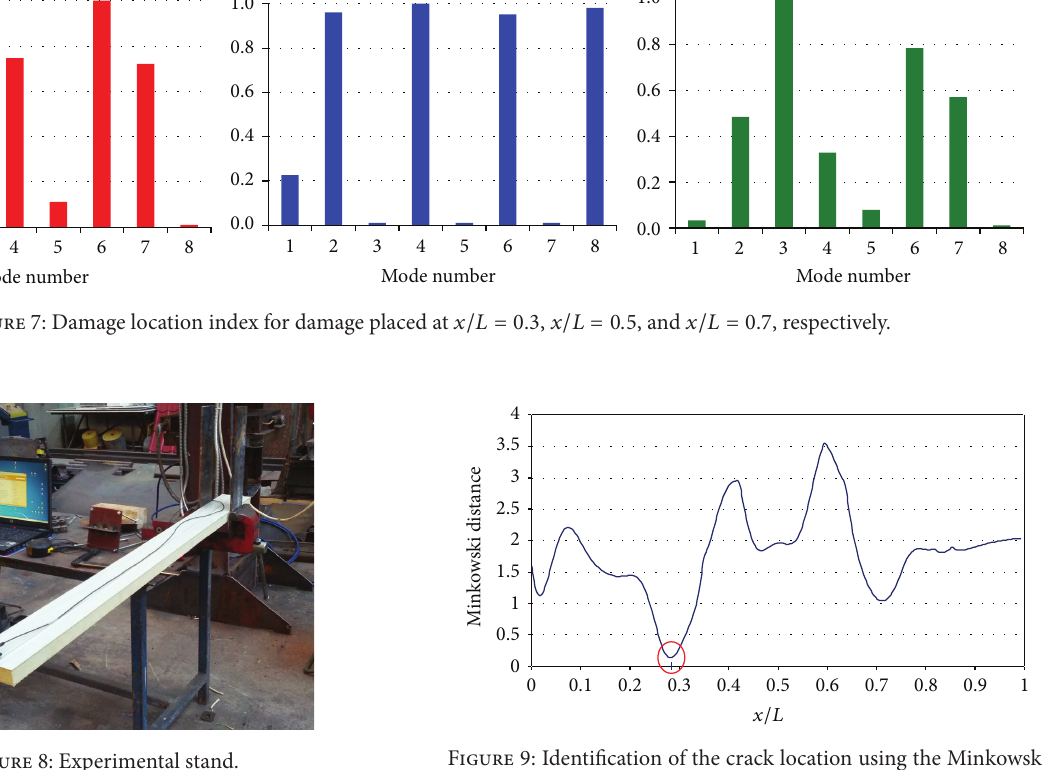
Figure 8: Experimental stand. Figure 9: Identification of the crack location using the Minkowski